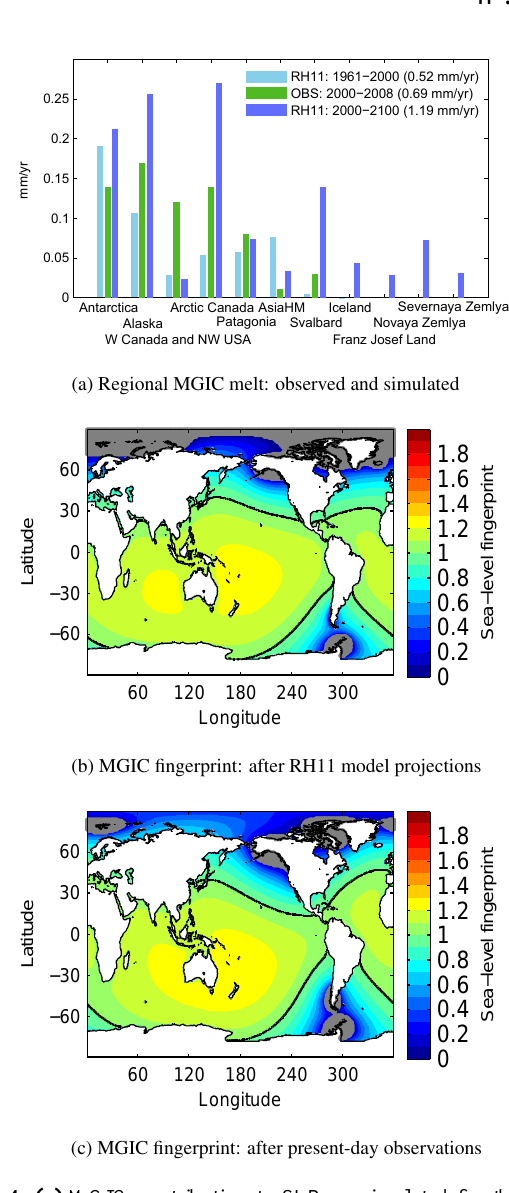
Fig. 4: (a) MGIC contribution to SLR as simulated for the Fig. 4. (a) MGIC contribution to SLR as simulated for the past past 1961-2000 period (RH11) (light blue), observed over 1961–2000 period (RH11) (light blue), observed over the recent the recent 2000-2008 period (see text) (green) and projected 2000–2008 period (see text) (green) and projected over the 2000– over the 2000-2100 period (RH11) (dark blue). (b,c) Corre- 2100 period (RH11) (dark blue). (b, c) Corresponding MGIC grav- sponding MGIC gravitational fingerprints computed after (b) itational fingerprints computed after (b) RH11 model projections RH11 model projections (the fingerprint used in this study) (the fingerprint used in this study) and (c) observations. The thick and (c) observations. The thick black line indicates the global black line indicates the global mean sea level change. Gray areas mean sea-level change. Gray areas indicate a sea-level fall. indicate a sea level